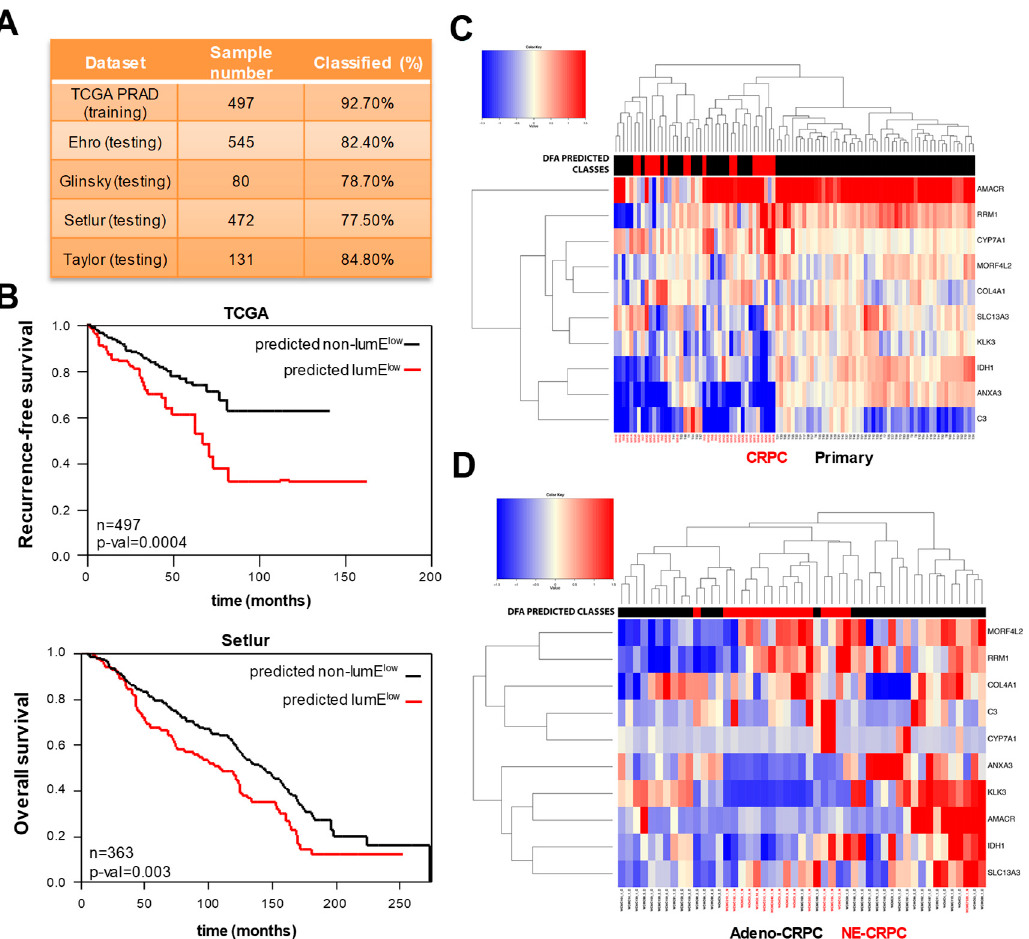
Figure 5. Extraction and validation of a 10-gene mini-classifier of prostate epithelial differentiation. ( A ) Percentage of correctly classified samples using the 10-gene classifier in prostate cancer datasets. The Cancer Genome Atlas (TCGA) cohort (training set) was used to obtain the predictor model using discriminant function analysis (DFA) and thereafter tested in Erho, Glinsky, Setlur, and Taylor (testing sets). ( B ) Kaplan–Meyer analysis of recurrence-free survival (TCGA) and overall survival (Setlur) based on the groups predicted by the 10-gene classifier. ( C ) Unsupervised hierarchical clustering of primary tumors and metastatic castration-resistant prostate cancers (CRPCs) based on the 10-gene classifier. Discriminant function analysis (DFA) predicted classes of low (red) and non-low (black) LumE tumors are indicated at the top. ( D ) Unsupervised hierarchical clustering of adenocarcinoma (adeno-CRPC) and neuroendocrine (NE-CRPC) CRPCs based on the 10-gene classifier. DFA predicted classes of low (red) and non-low (black) LumE